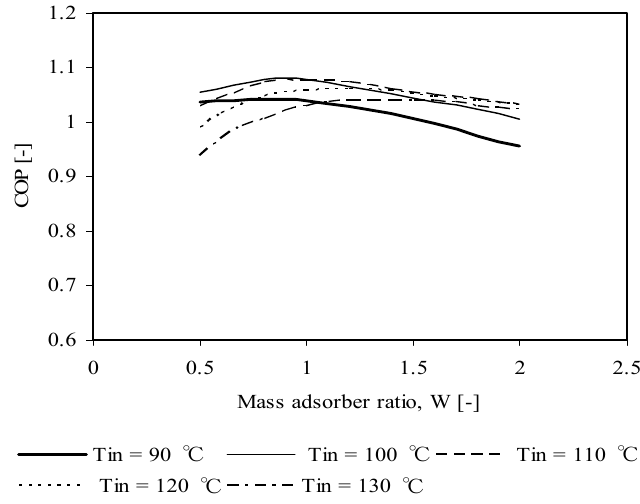
Figure 7. The influence of the mass adsober ratio on the COP.